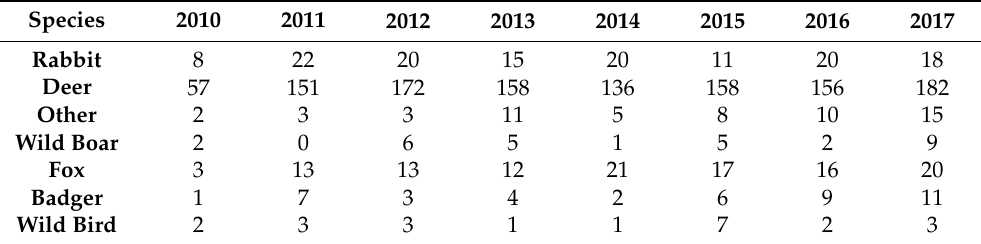
Table 1. The annual distribution of WVCs per species.